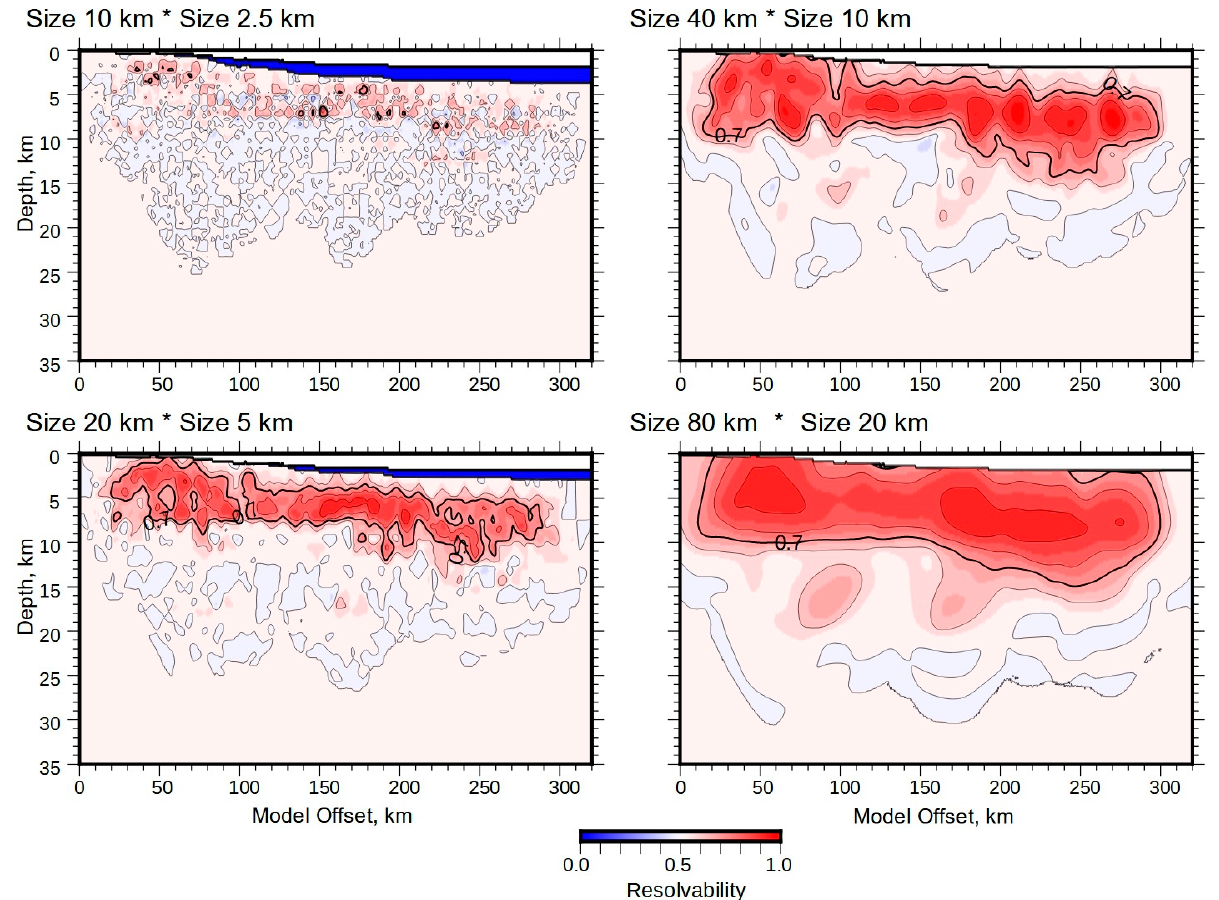
Figure 7. Model resolvability at four different disturbance cell sizes. When resolvability is greater or equal to 0.7, the velocity model is deemed recoverable. H110 is basically resolvable for perturbation, using cell size 20 km, and completely resolvable to ~9 km deep for coarser cell size 20, 40, and 80 km.